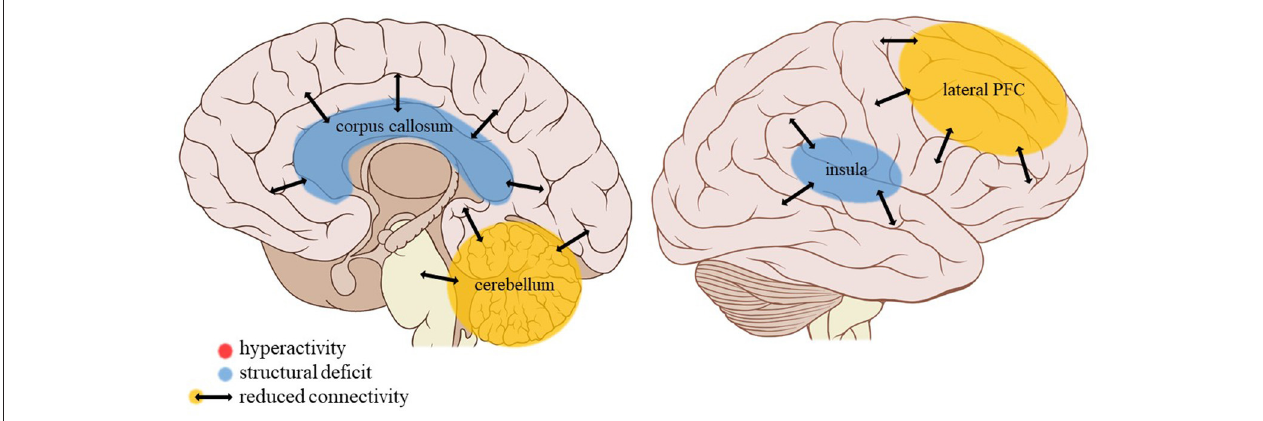
FIGURE 5 | Neuroimaging findings associated with neglect. PFC, prefrontal cortex. Adapted from: Patrick J. Lynch, medical illustrator; C. Carl Jaffe, MD, cardiologist.